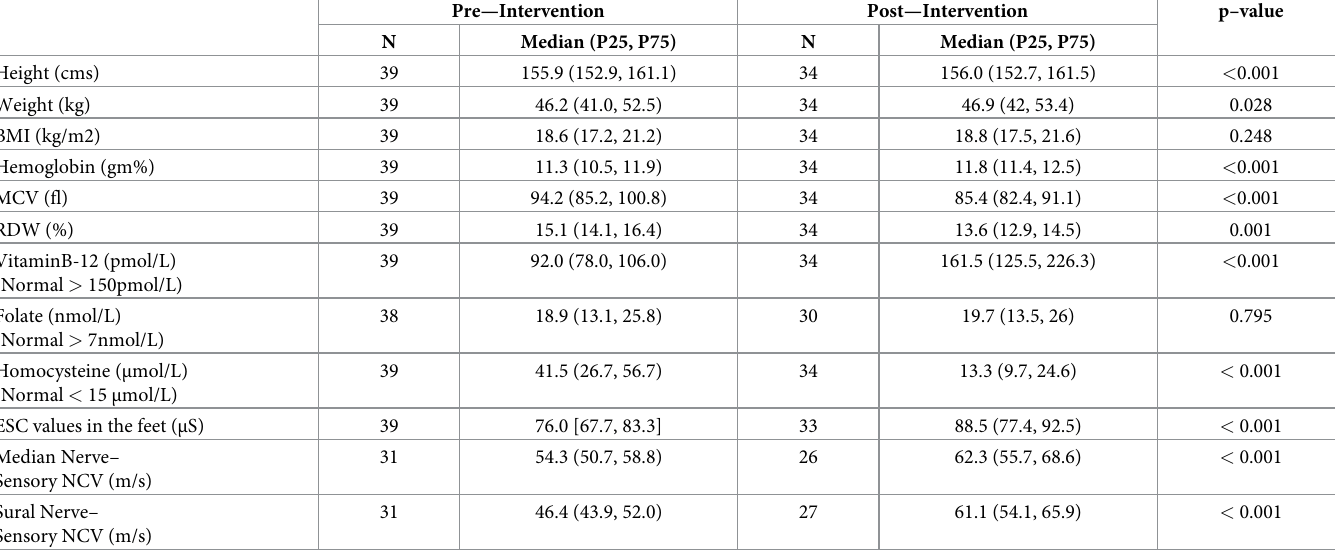
Table 1. Comparison of clinical, hematological and nerve function measurements before and after 11 months of